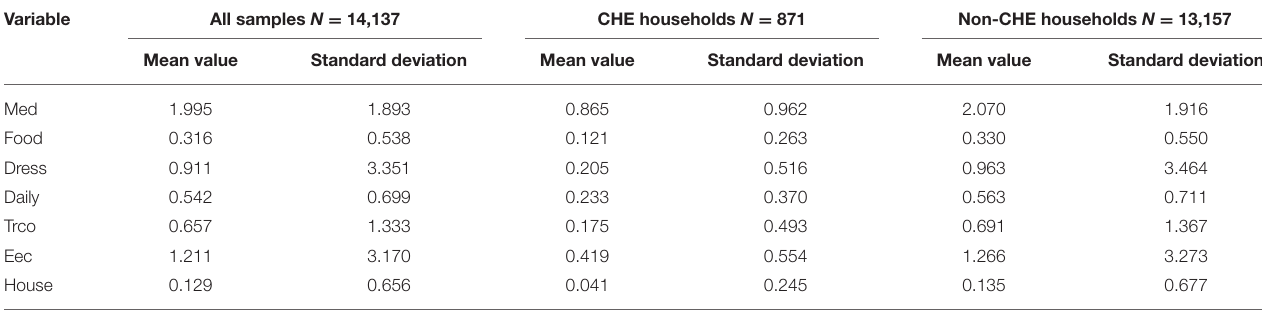
TABLE 3 | Statistics of mean consumption expenditure in the catastrophic health expenditure (CHE) and non-CHE groups. Variable